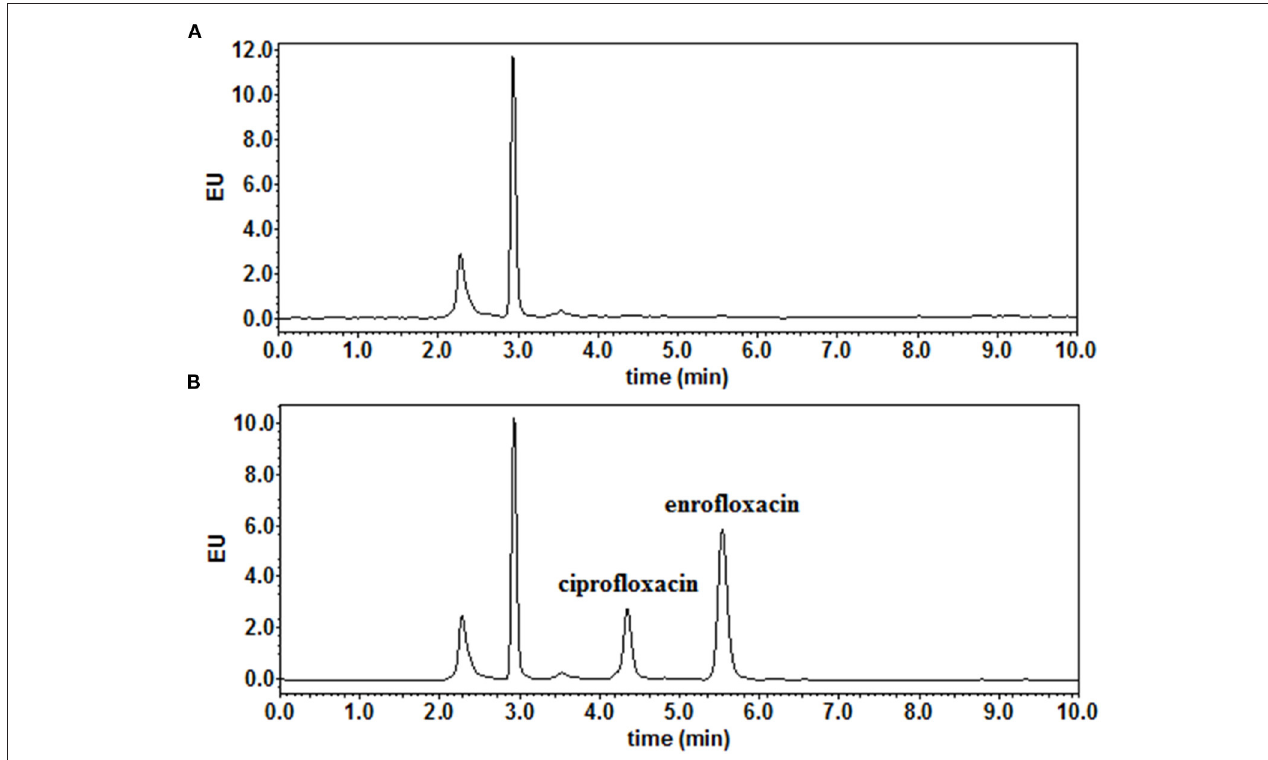
FIGURE 1 | The representative chromatograms of (A) blank muscle/skin matrices of crucian carp and (B) muscle/skin samples spiked at 0.03 µ g/g of enrofloxacin and